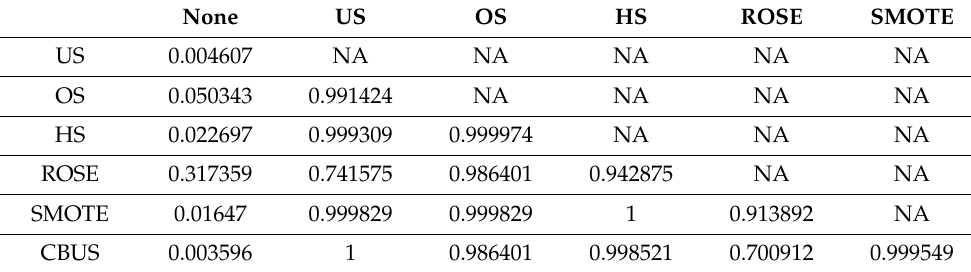
Table 8. Post hoc analysis using Nemenyi multiple comparison test for DT.